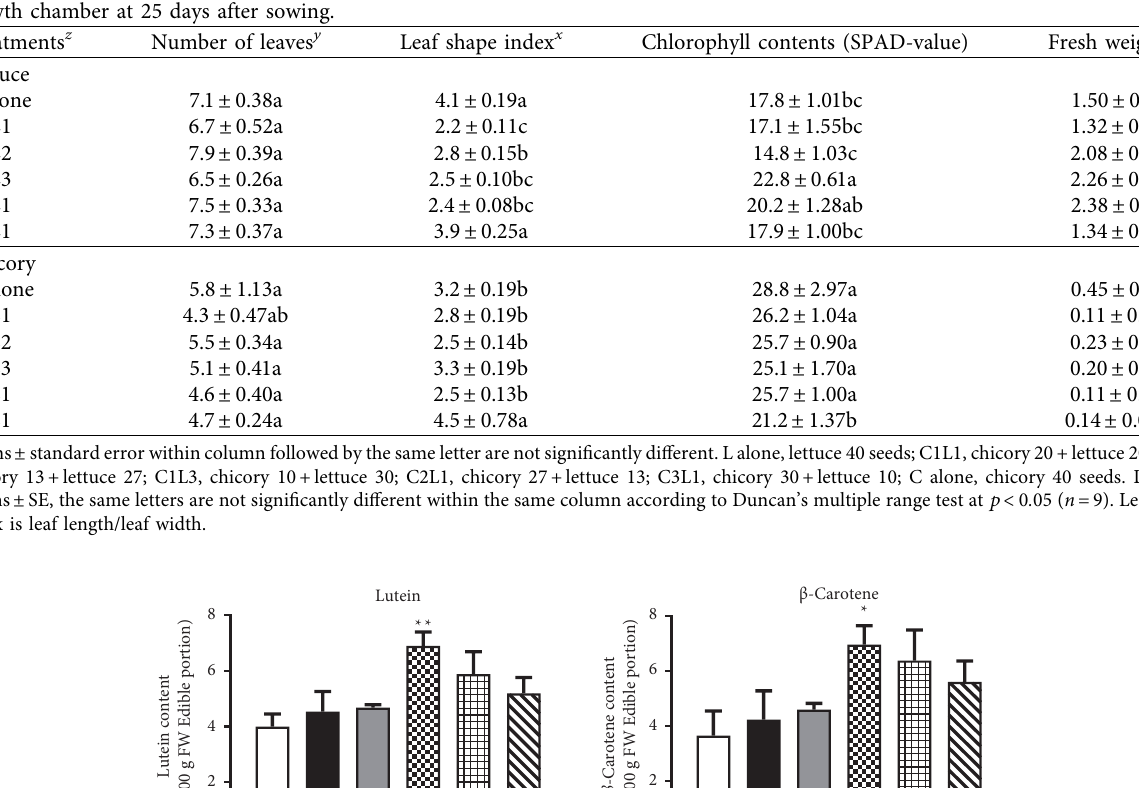
Table 3: Plant growth parameters of lettuce ( Lactuca savita ) and chicory ( Cichorium intybus ) according to seed mixture ratio in LED plant growth chamber at 25 days after sowing.